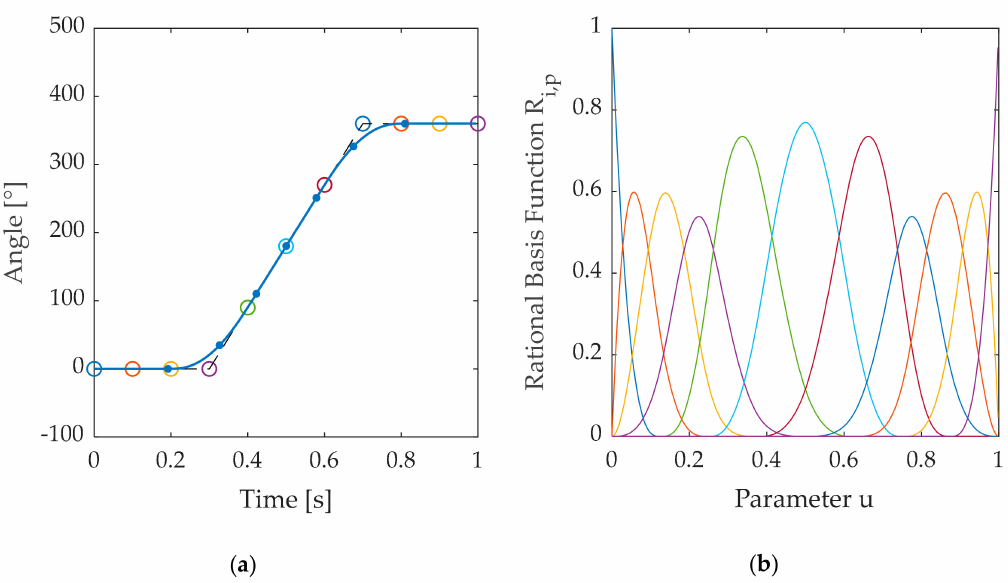
Figure 2. ( a ) Example of a Non-Uniform Rational B-Spline (NURBS) curve and ( b ) the corresponding rational basis functions R i , p with ω = [ 1 1 1 1 3 5 3 1 1 1 1 ]